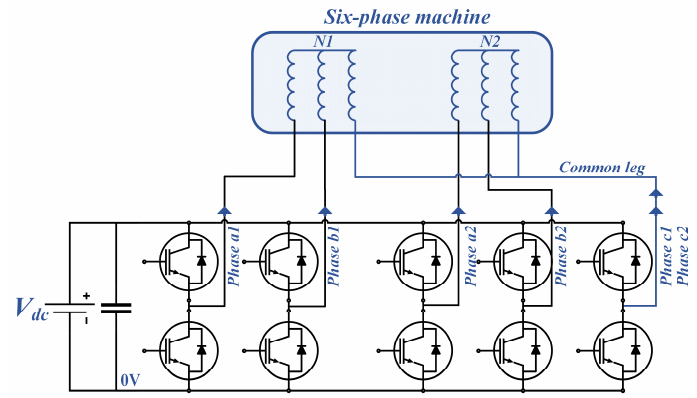
Figure 20. Topology 1: Structure of a five-leg inverter for a six-phase machine.